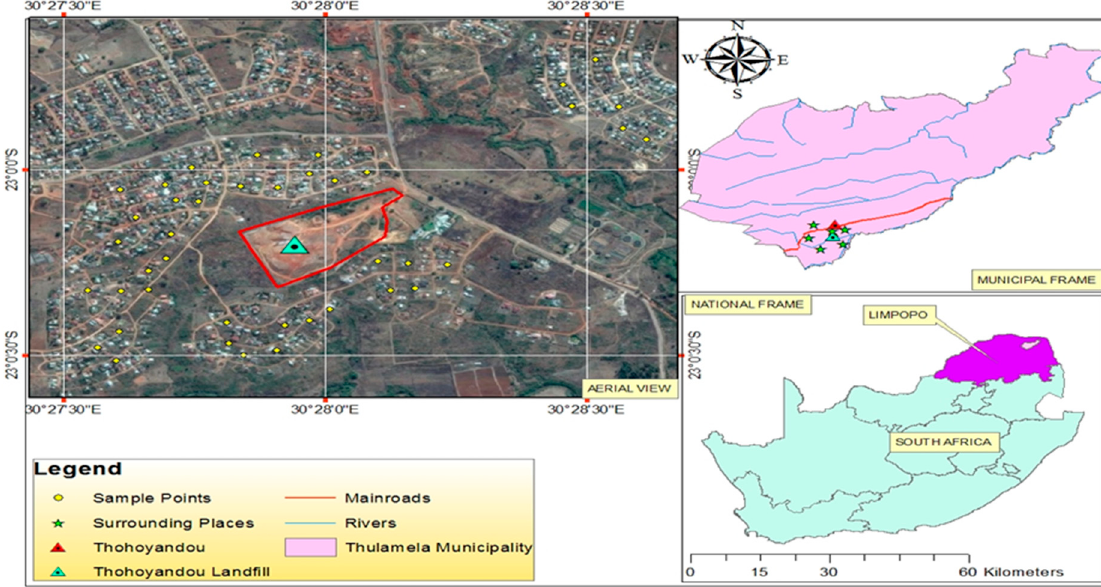
Figure 1. Thohoyandou landfill site and nearby residents.